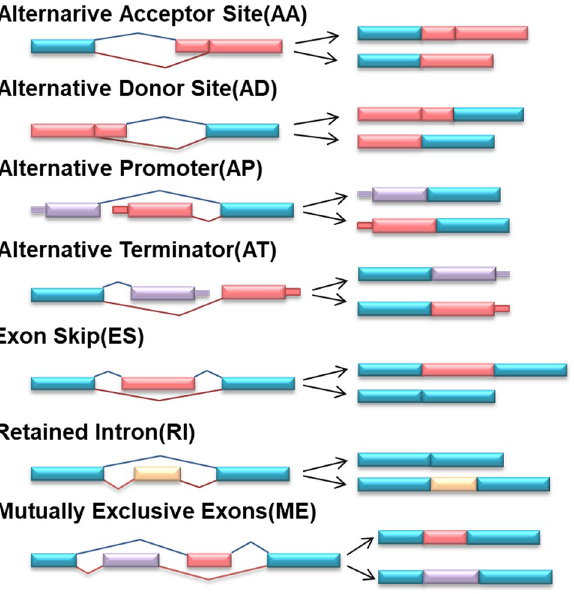
Figure 6. Illustration of seven types of AS events: alternative acceptor (AA), alternative donor site (AD), alternative promoter (AP), alternative terminator (AT), exon skip (ES), retained intron (RI), and mutually exclusive exons